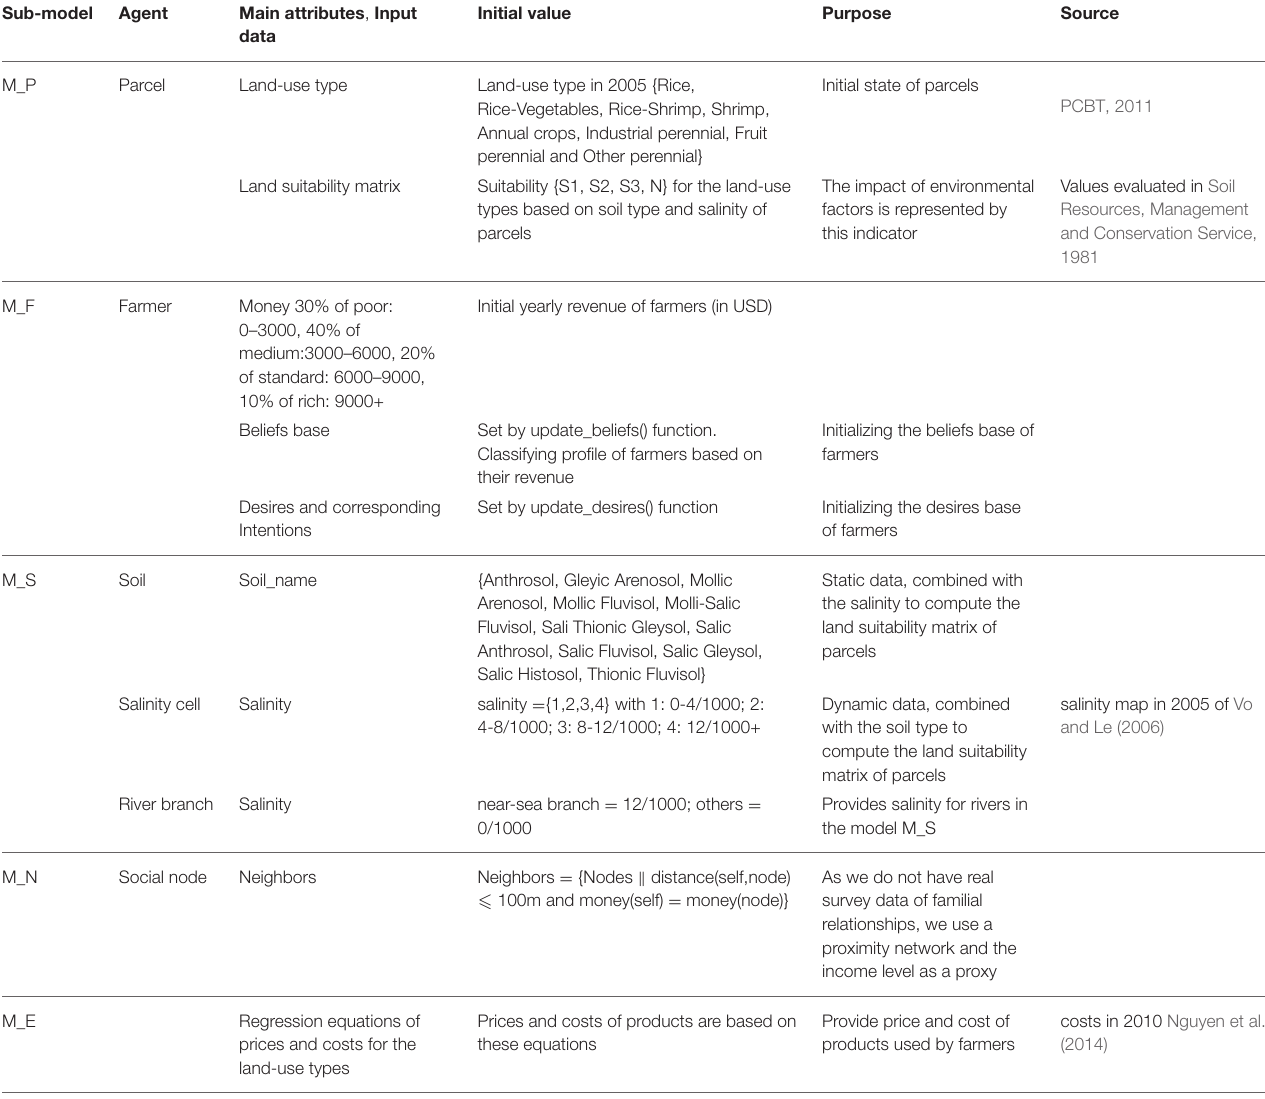
TABLE 3 | Initialization.